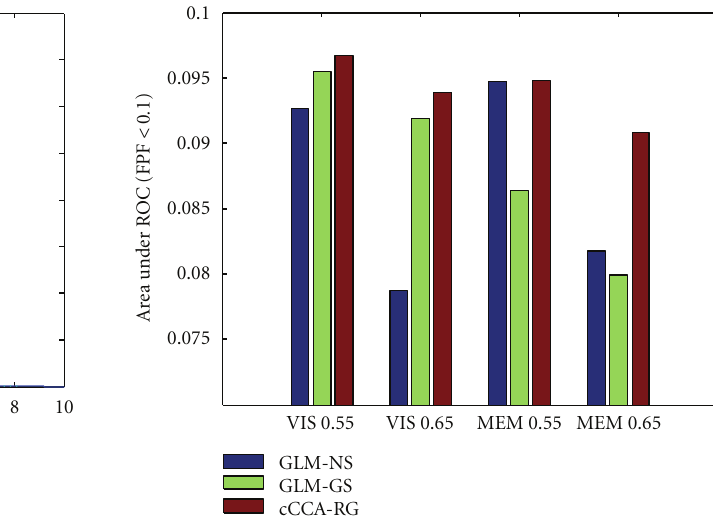
Figure 4: Detection performance of di ff erent data analysis methods showing the area under the ROC curve (AUR), integrated over FPF ∈ [0,0 . 1], using pseudoreal data. The AURs for the contrast V-F of the visual paradigm (“VIS 0.55” and “VIS 0.65”) and the contrast E-C of the memory paradigm (“MEM 0.55” and “MEM 0.65”) are shown for the low noise case ( f = 0 . 55) and the high noise case ( f = 0 . 65), respectively. The cCCA-RG achieves the greatest AUR values in all